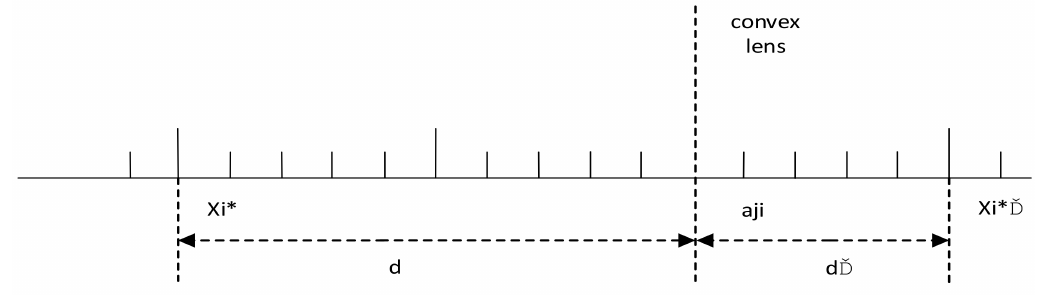
Figure 2. One dimensional inverse learning strategy diagram based on lens imaging